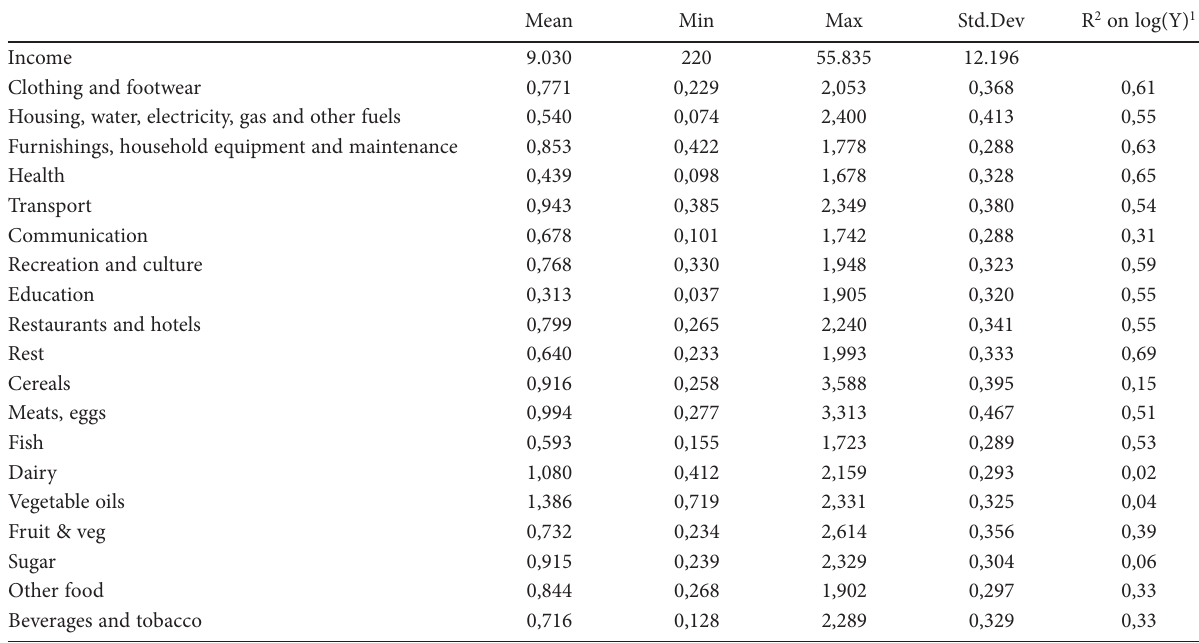
Table 3. Statistics on income and